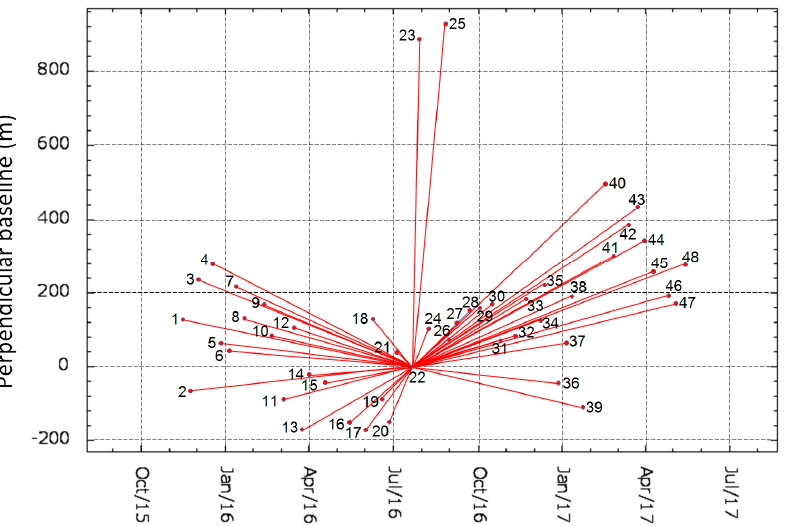
Figure 5. Normal Baselines used for the PSI analysis (reference acquired on 22 July 2016).